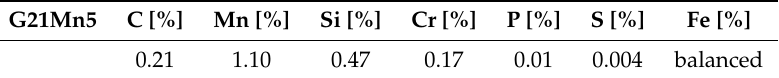
Table 1. Chemical composition of the investigated material in weight percent.